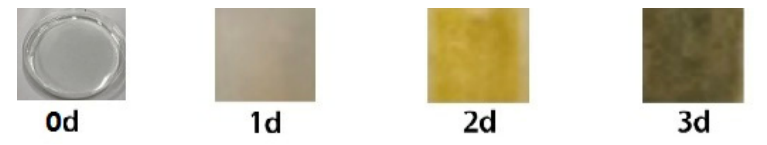
Figure 1. Growth of Aspergillus flavus on the medium. When Aspergillus flavus was inoculated on corn grains, the amount of Aspergillus flavus gradually increased and the color of corn changed significantly with the increase in time, as shown in Figure 3. The SERS of Aspergillus flavus inoculated on corn grains shown in Figure 4 was similar to that inoculated on the medium, and they had the same fingerprints at 400–1800 cm − 1 . Moreover, the intensity of Raman characteristic peak at 1536–1537 cm − 1 increased obviously with the growth of culture time of Aspergillus flavus on corn in different culture periods. The experimental results shown from the SERS of Aspergillus flavus were consistent with the color changes observed directly on